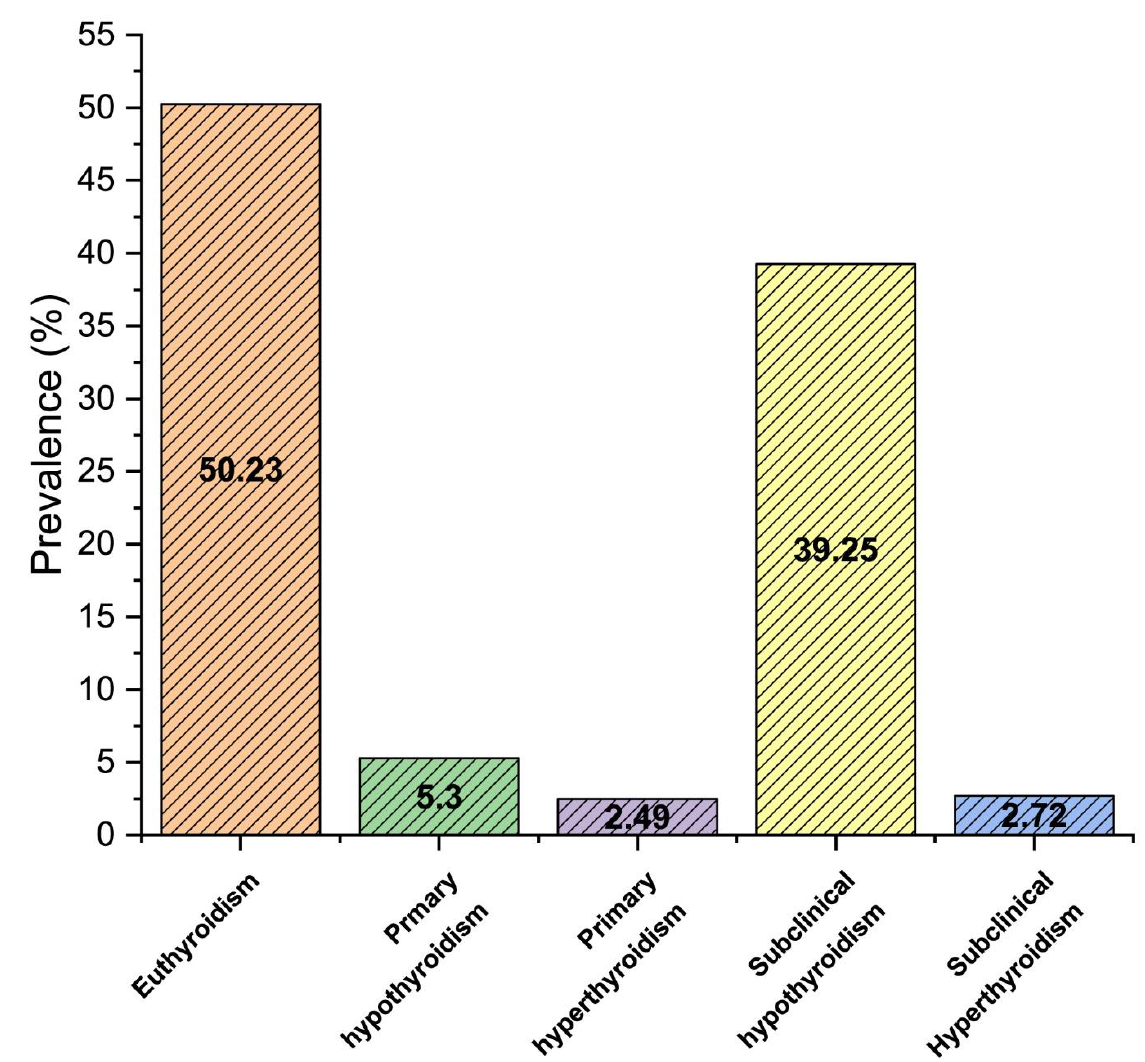
Figure 1. The overall prevalence of thyroid dysfunction in the study population. Further detailed analysis of thyroid dysfunction stratified by gender and age group is presented in Table 3. Most age subgroups in females demonstrated a significantly higher prevalence of thyroid dysfunction than the opposite gender of same age sub- groups ( p < 0.05). Among different age subgroups in females, the prevalence of subclinical hypothyroidism was significantly higher in young females (<20 and 20–30 years) ( p < 0.05). However, a significantly high prevalence of subclinical hypothyroidism was observed in males below 20 and 31–40 years ( p < 0.05). The overall prevalence of thyroid dysfunction among the study population stratified by the age subgroup is presented in Table